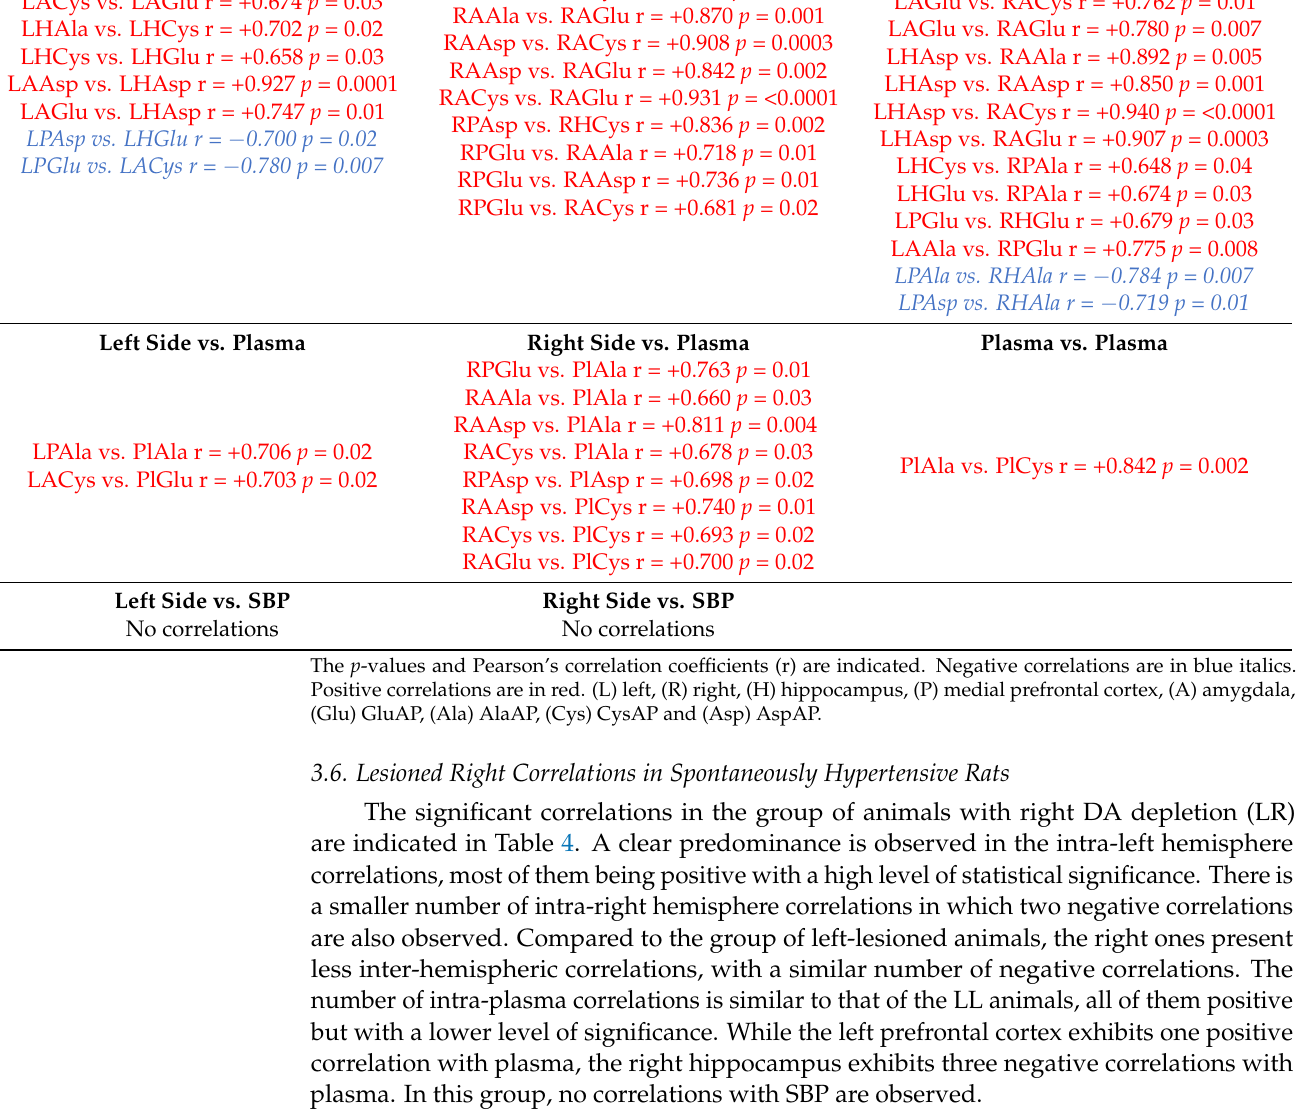
Table 2. Intra- and inter-hemispheric correlations between brain aminopeptidase activities; between plasma aminopeptidase activities; between plasma aminopeptidase activities versus brain aminopep- tidase activities and between aminopeptidase activities versus systolic blood pressure (SBP) in sham right spontaneously hypertensive rats (SHR). Sham Right SHR Intra-Hemispheric Inter-Hemispheric Sham Right (Left vs. Left) Sham Right (Right vs. Right) Sham Right (Left vs. Right) LAAla vs. RAAla r = +0.638 p = 0.04 LAAsp vs. RAAla r = +0.917 p = 0.0002 LAAsp vs. RAAsp r = +0.852 p = 0.001 LAAsp vs. RACys r = +0.852 p = 0.001 LAAsp vs. RAGlu r = +0.902 p = 0.0004 LAGlu vs. RAAla r = +0.888 p = 0.0006 LAAla vs. LAGlu r = +0.757 p = 0.01 LAGlu vs. RAAsp r = +0.830 p = 0.002 LAAsp vs. LAGlu r = +0.826 p = 0.003 LAGlu vs. RACys r = +0.762 p = 0.01 LACys vs. LAGlu r = +0.674 p = 0.03 LHAla vs. LHCys r = +0.702 p = 0.02 LHCys vs. LHGlu r = +0.658 p = 0.03 LAAsp vs. LHAsp r = +0.927 p = 0.0001 LAGlu vs. LHAsp r = +0.747 p = 0.01 LPGlu vs. LACys r = − 0.780 p = 0.007